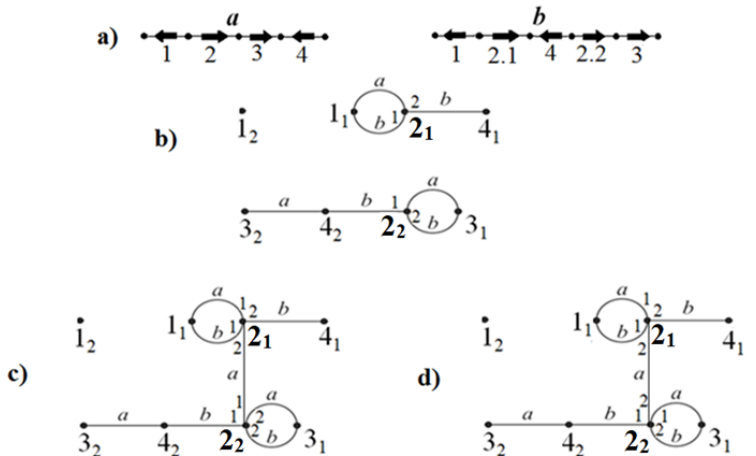
Figure 2. ( a ) Structures a and b. ( b ) Their breakpoint graph a + b . ( c ) Change in a + b after a linear duplication D of edge 2 in a. ( d ) Change after the cyclic duplication D of the same edge (recall that a loop has two endpoints).